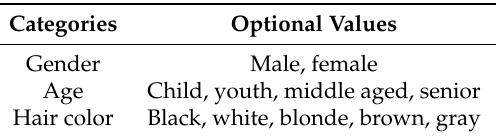
Table 2. Attributes of humans.